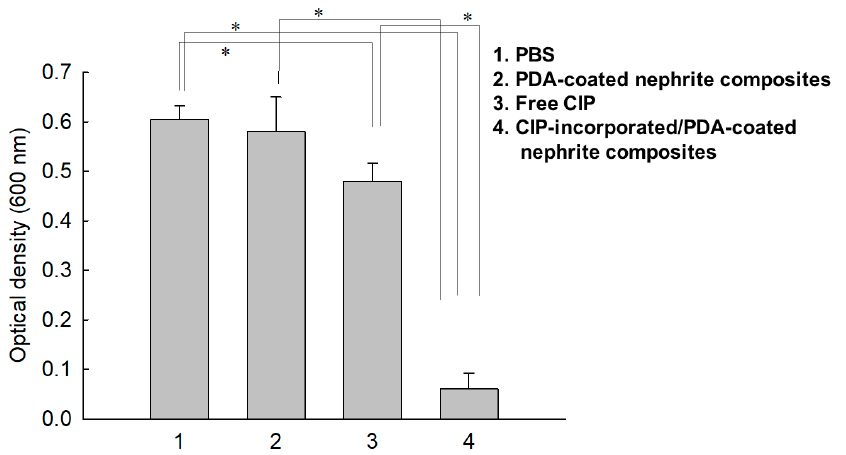
Figure 7. Antibacterial activity of CIP-incorporated/PDA-coated nephrite composites (CIP/dopamine/nephrite ratio = 0.2/1.0/1.0). For CIP and composite treatment, CIP concentration was adjusted to (0.1 mg CIP/0.5 mL PBS) and then each component was put into a dialysis membrane. PBS was used as a control and the same amount of PDA-coated nephrite composites was used for comparison. *: p < 0.01.